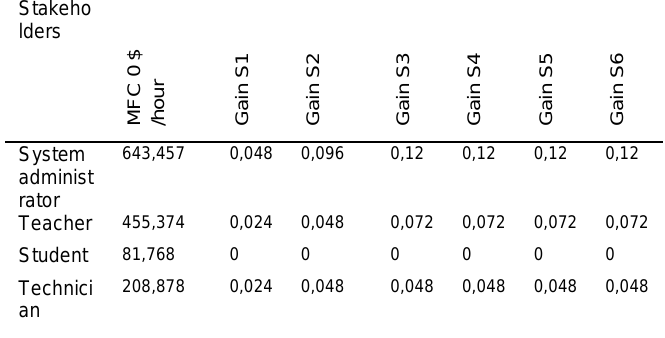
Table 16: Gain for the web server